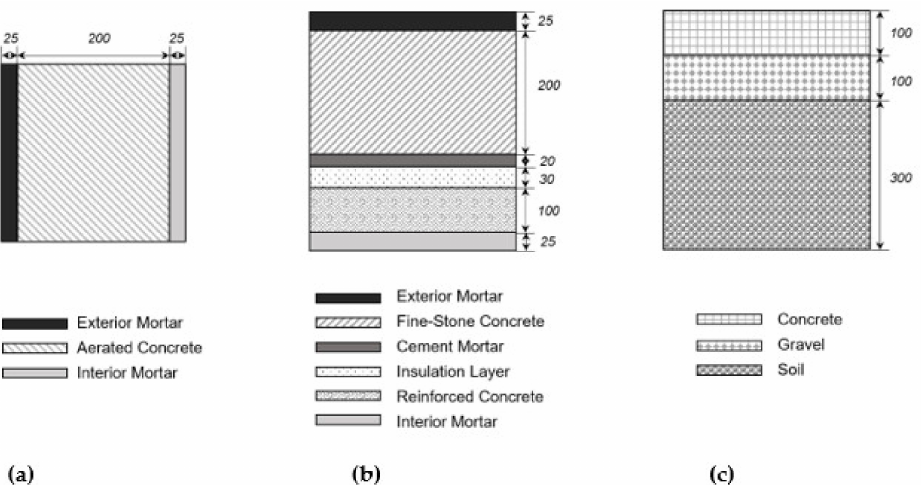
Figure 2. Structures of the ground and buildings (wall and roof): ( a ) Building wall; ( b ) Roof; ( c )